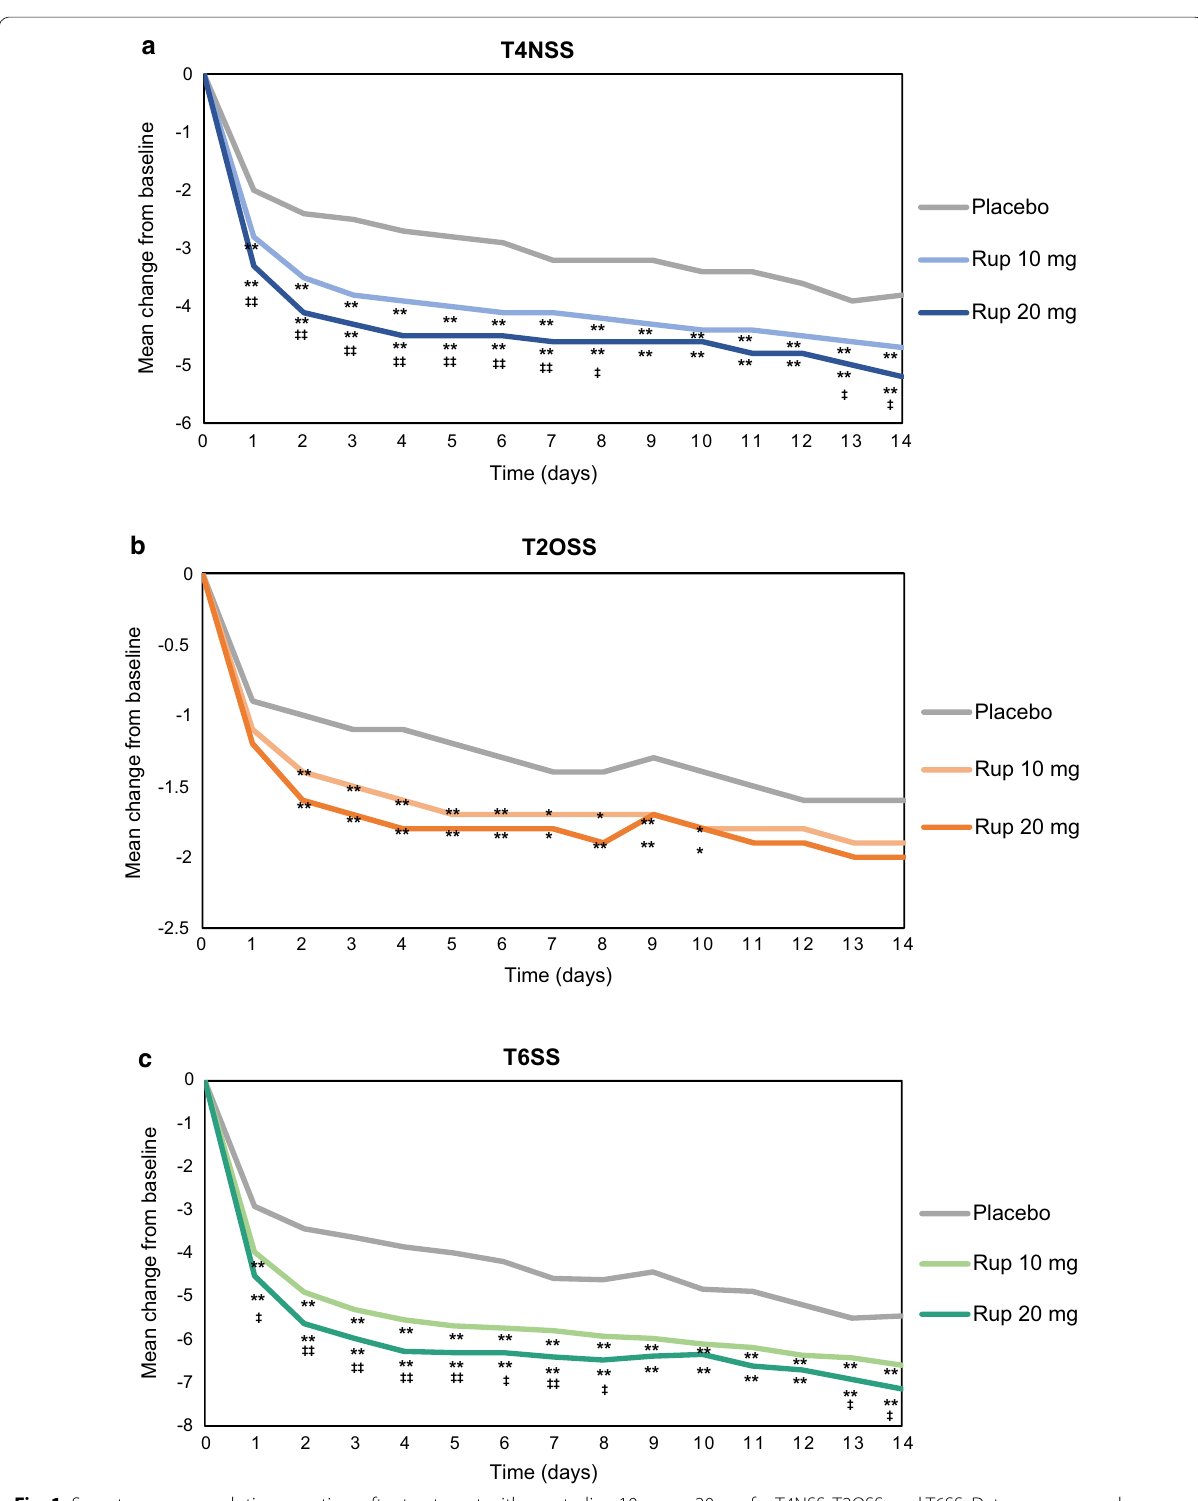
Fig. 1 Symptom score evolution over time after treatment with rupatadine 10 mg or 20 mg for T4NSS, T2OSS, and T6SS. Data are expressed as mean change from baseline over time of treatment for: a T4NSS, b T2OSS, and c T6SS. Statistical significance was calculated with the Mann–Whitney test. * p < 0.05; ** p < 0.01 (rupatadine groups vs placebo); ‡ p < 0.05; ‡‡ p < 0.01 (rupatadine 10 mg vs rupatadine 20 mg). T4NSS Total 4 Nasal Symptom Score, T2OSS Total 2 Ocular Symptom Score, T6SS Total 6 Symptom